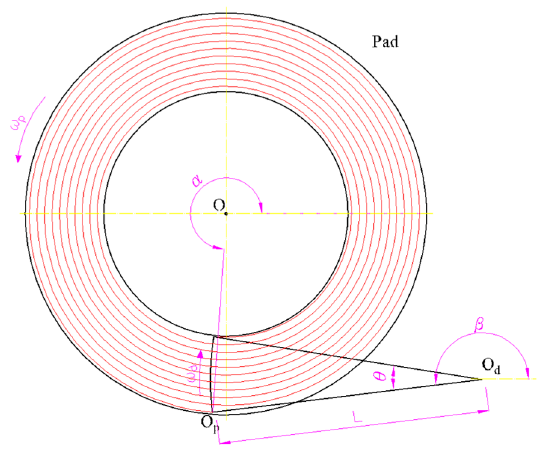
Figure 2. Schematic of scanning locus of confocal sensor.